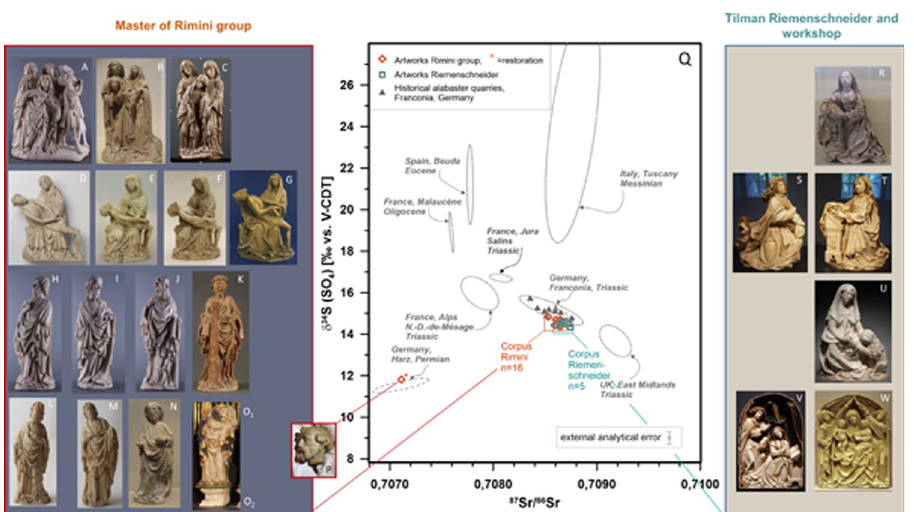
Fig 3. A-M: Master of Rimini group. A-C : Swooning Mary groups (A: Liebieghaus Museum, Rimini altarpiece, B: Louvre Museum, C: National Museum of Warsaw); D-G : Piet à s (D: Rijksmuseum, Amsterdam, E: